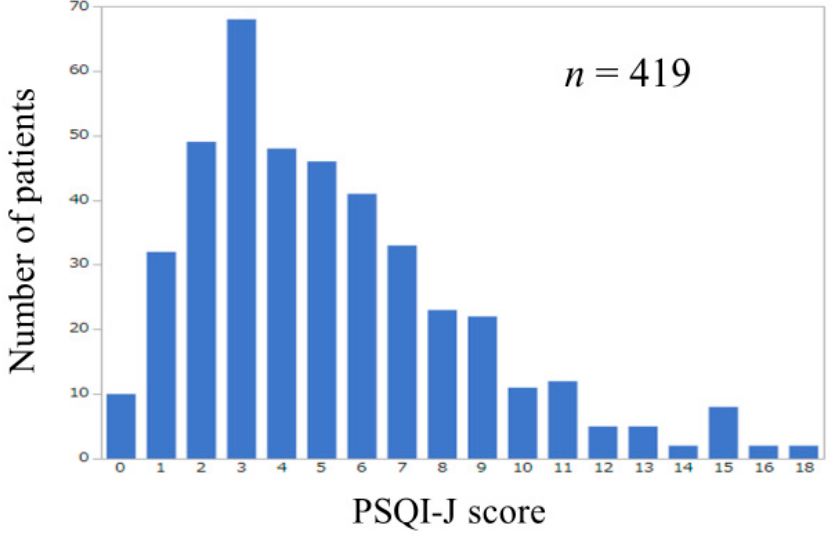
Figure 1. Number of patients according to PSQI-J score ( n = 419).